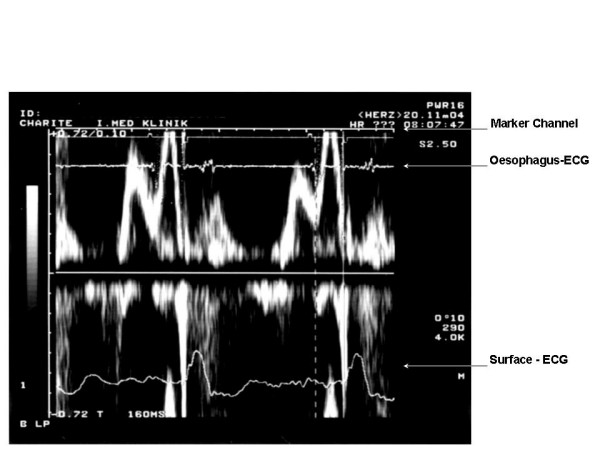
Assessment of the left-atrial electromechanical action = LA-EAClong. LA = left atrial deflection (see oesophagus- ECG). EAClong = the end of the A-wave in an unphysiologically long AV-intervall. In this particular patient the LA-EAClang is 160 ms